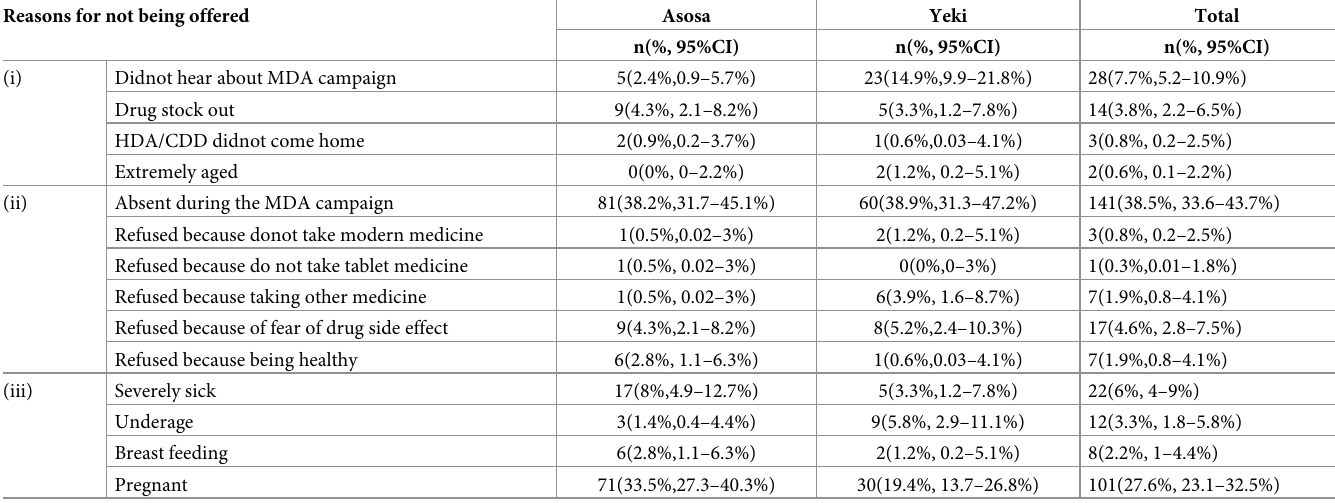
Table 2. Reasons for not offering/receiving ivermectin in Asosa and Yeki districts during May 2017 MDA campaign.